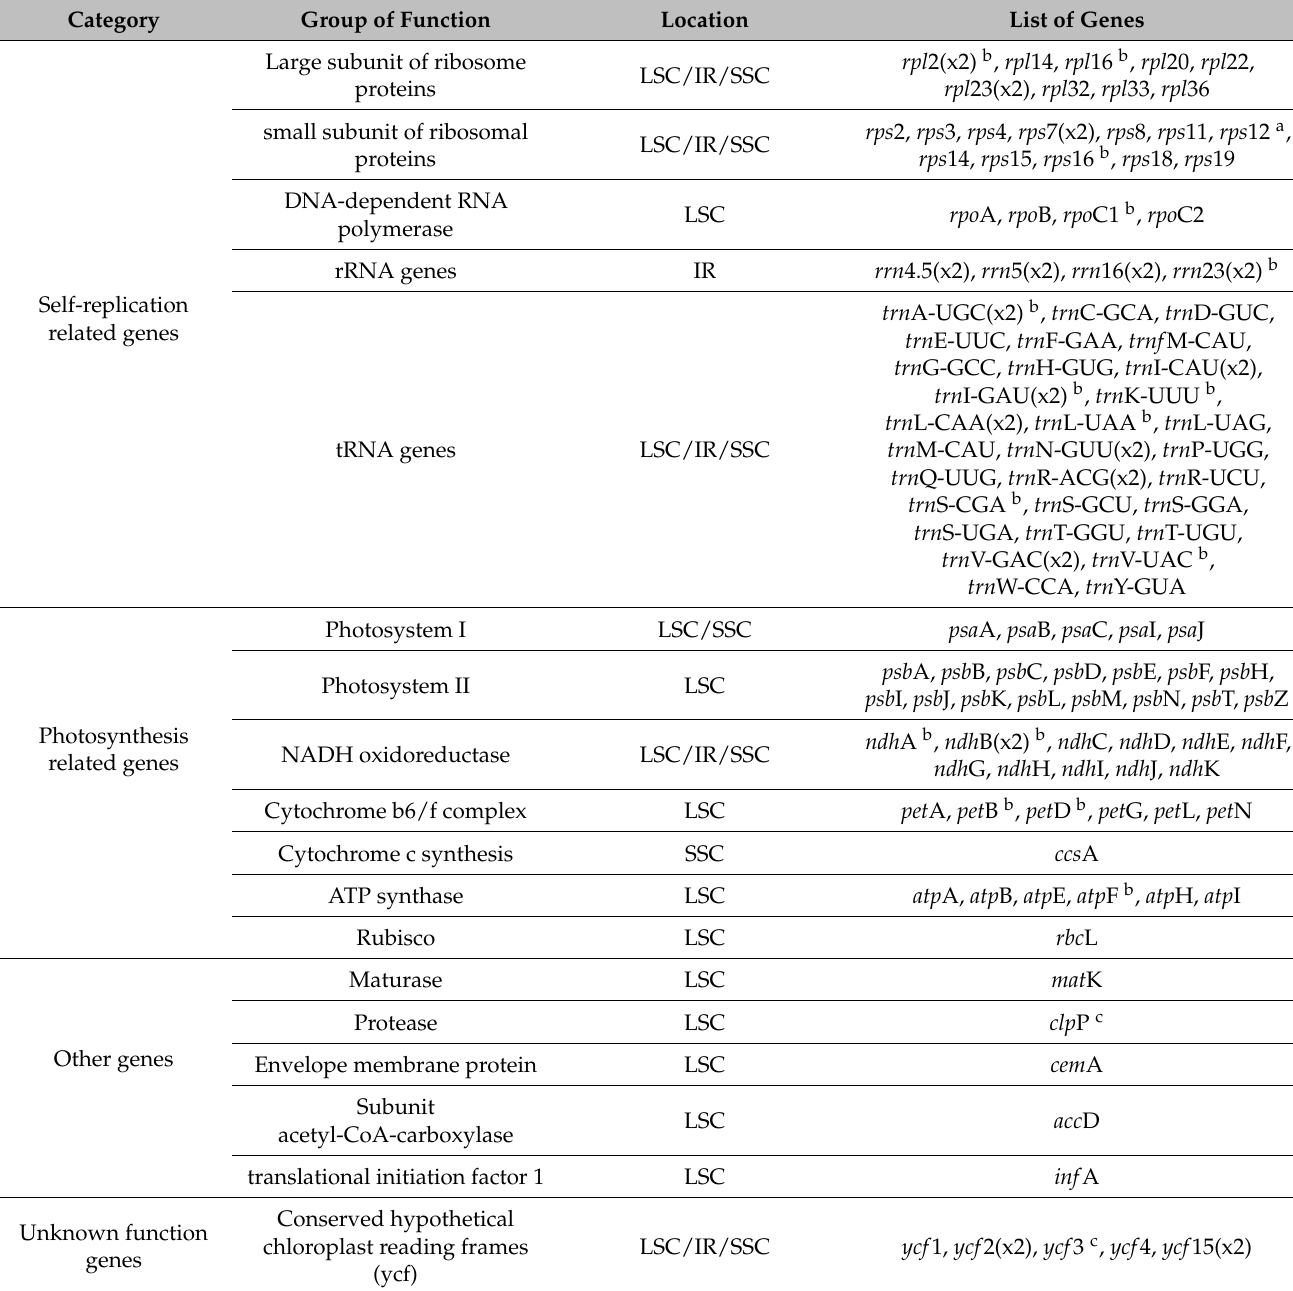
Table 2. List of annotated genes in the five Barleria chloroplast